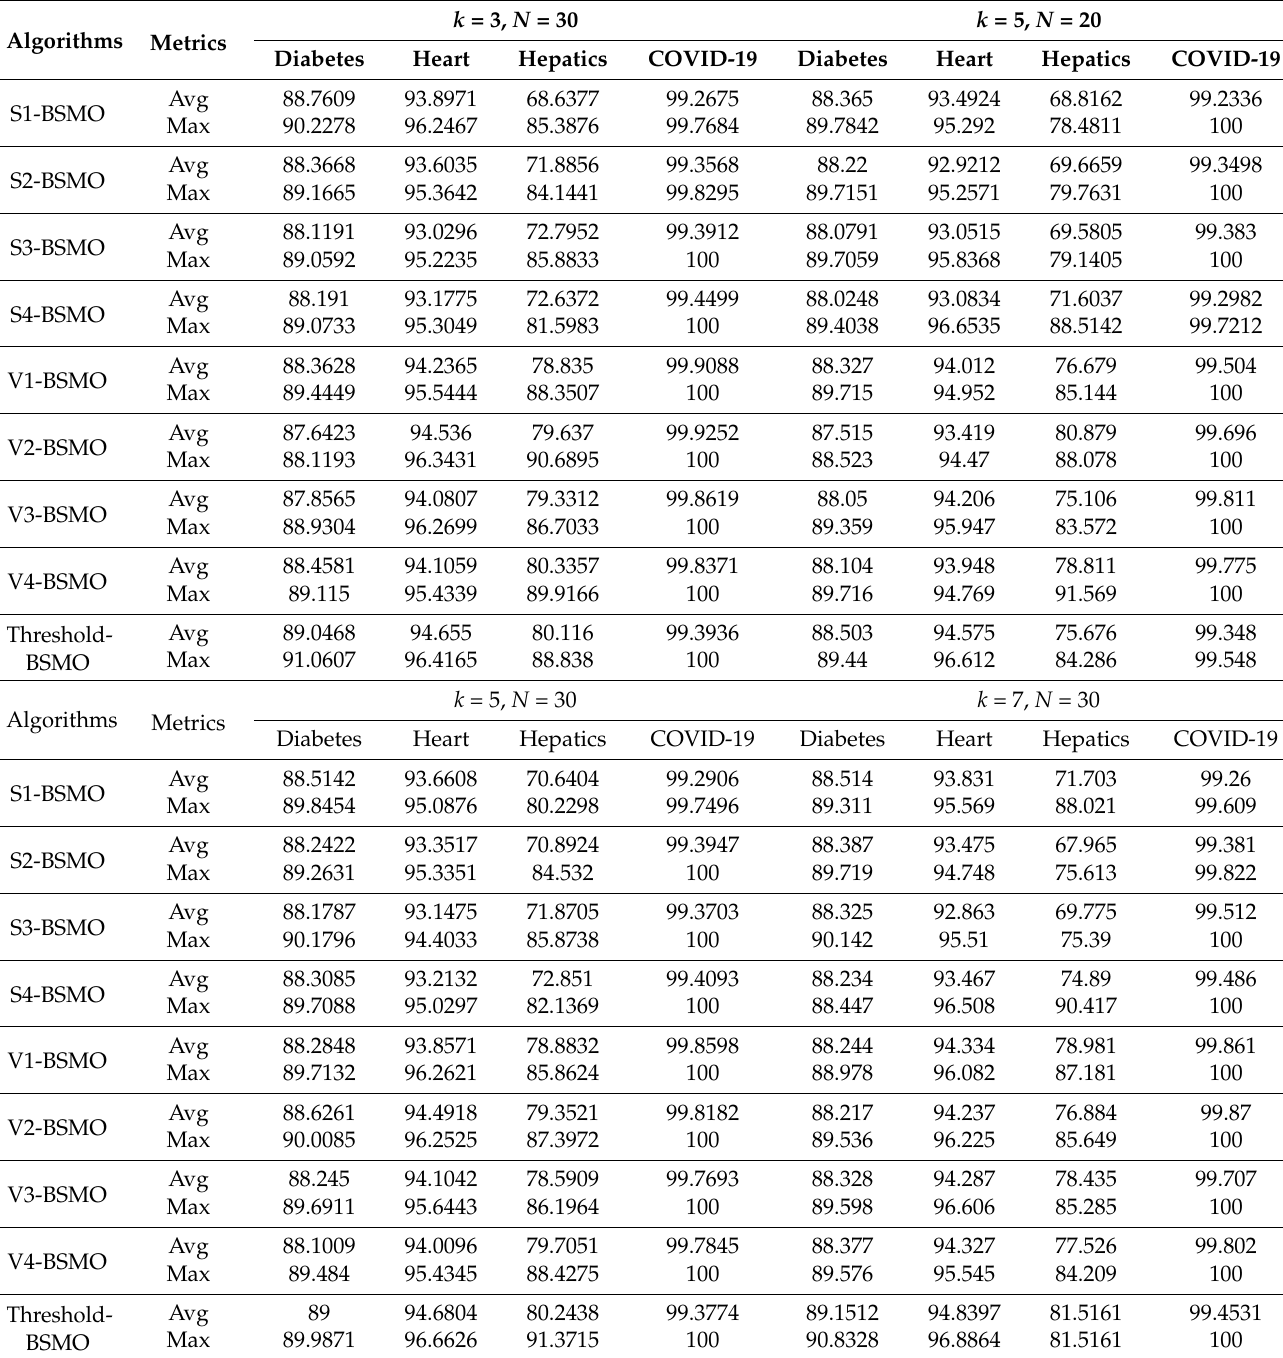
Table A4. Parameters setting of BSMO algorithm in terms of sensitivity